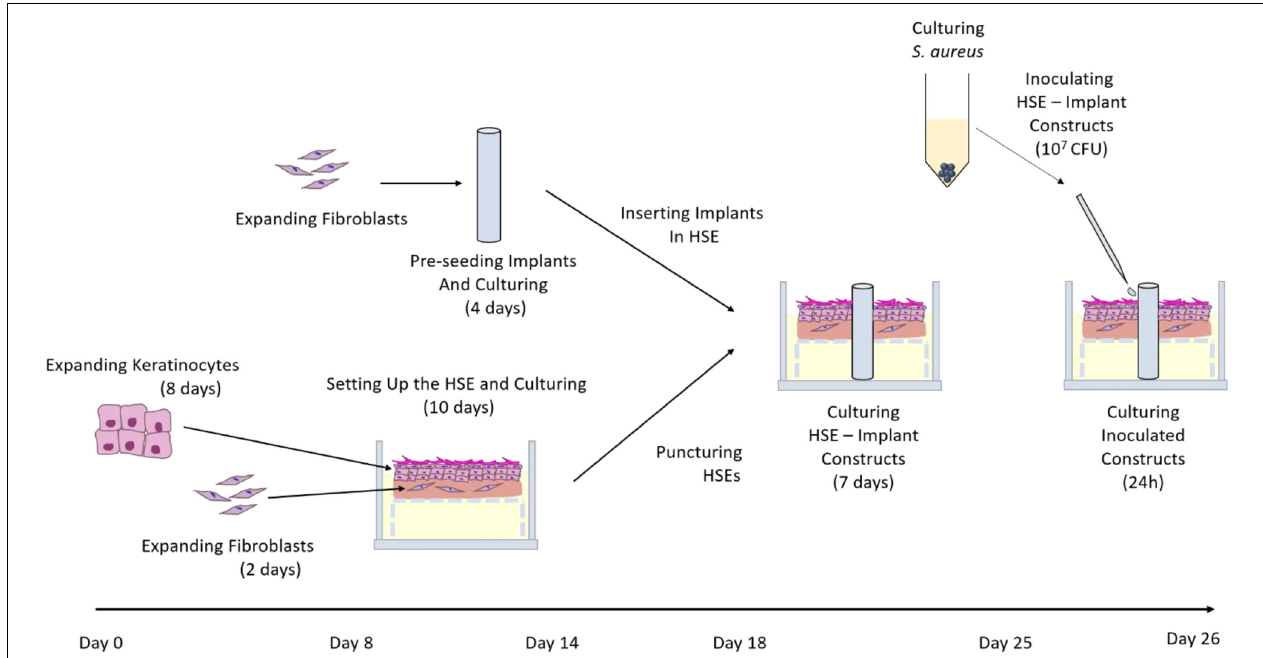
FIGURE 1 | Summary of in vitro HSE-driveline infection model establishment. Human primary fibroblasts and keratinocytes were expanded and seeded onto a de-epidermised and de-cellularised dermis. Simultaneously, fibroblasts were expanded, seeded onto drivelines and cultured for 4 days. Skin constructs were punctured on the 10th day of culture and the three types of mock drivelines (smooth PCL, porous un-seeded, and porous pre-seeded) were inserted. The skin-driveline constructs were cultured for another 7 days prior to challenge with 10 7 CFU directly S. aureus ATCC 29213 directly at the skin-driveline interface. At 24 hpi samples were either processed for enumeration of viable bacteria or fixed, sucrose infiltrated and snap frozen for subsequent histological analysis.